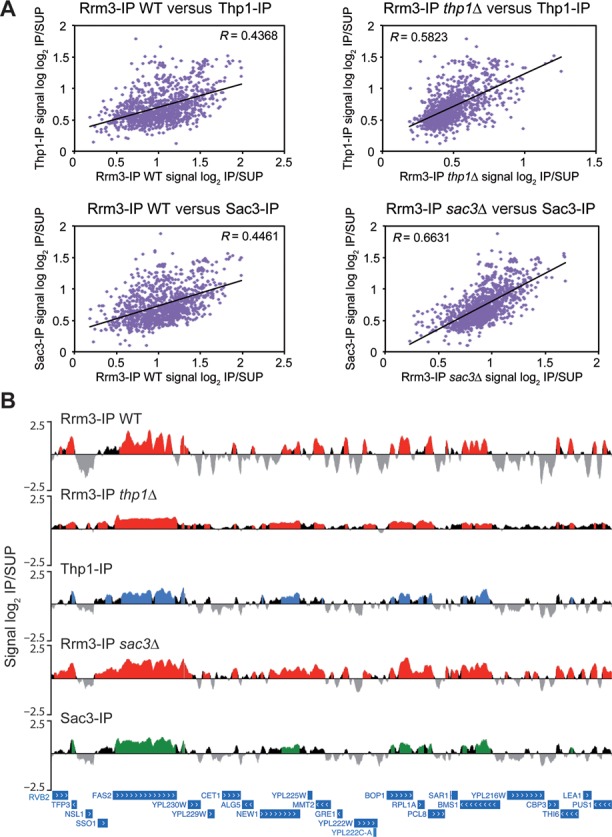
Analysis of Rrm3-enriched genes in wild-type, thp1Δ and sac3Δ cells. (A) Correlation analysis of Thp1, Sac3 and Rrm3 enrichment levels in thp1Δ and sac3Δ cells. Scatter plots showing correlation among Thp1, Sac3 and Rrm3 enrichment levels in the common ORFs detected by ChIP-chip in wild-type and mutant strains, represented as signal log2 IP/SUP ratio. A linear regression line and the Pearson's R correlation coefficient are plotted per graph. The complete list of genes can be found in the Supplementary Dataset II. (B) Similar distribution of Thp1, Sac3 and Rrm3 along the genome. Thp1, Sac3 and Rrm3 binding to a fragment of chromosome XVI detected by ChIP-chip and represented as signal log2 IP/SUP ratio is shown. Red (Rrm3-IP), blue (Thp1-IP) and green (Sac3-IP) histograms (online version) represent the statistically significant protein binding clusters (P < 0.01, minimum run >100 bp, maximum gap <250 bp). Genes and other features are represented according to the SGD.